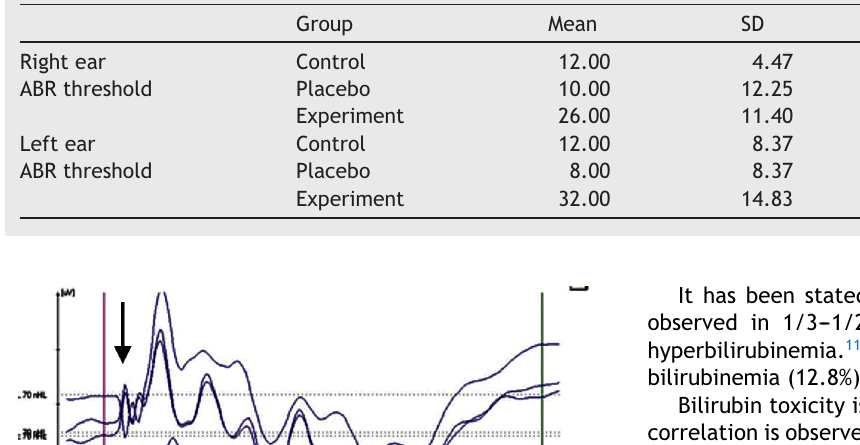
Mean threshold of ABR in right and left ears (dB nHL).